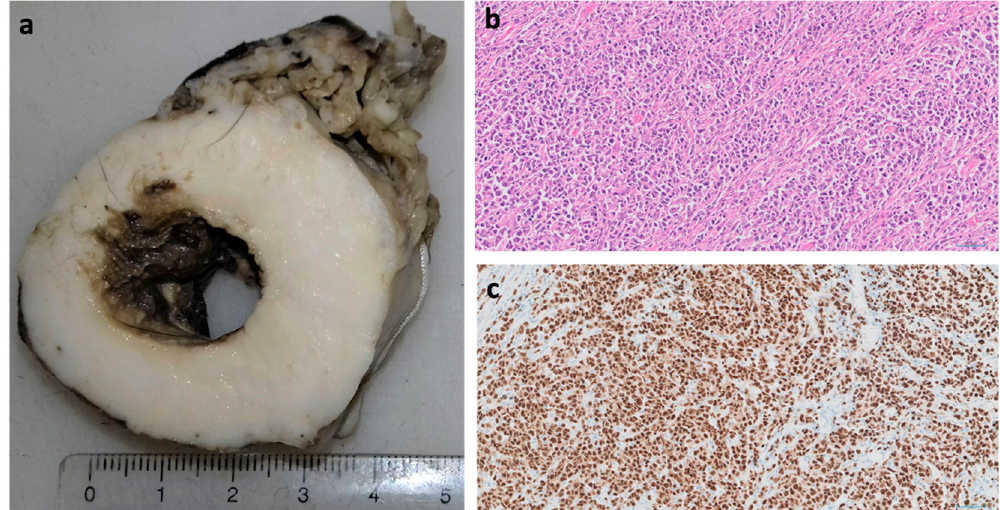
Figure 2. A case of a gastrointestinal B-cell lymphoma in a cat. An 8-year old female Domestic short hair cat presenting with an abdominal mass underwent surgery to remove the lesion, which was sent for histopathologic examination. ( a ) Macroscopic image of the excised mass (the area in white is the tumour). ( b ) Microscopic image of a representative section of the mass showing neoplastic cells arranged in sheets or infiltrating between and sometimes separating pre-existing tissue structure (HE- stained, × 20 magnification). ( c ) Immunohistochemistry image of the lymphoma showing positivity for Pax5, confirming it is of B-cell origin ( × 20